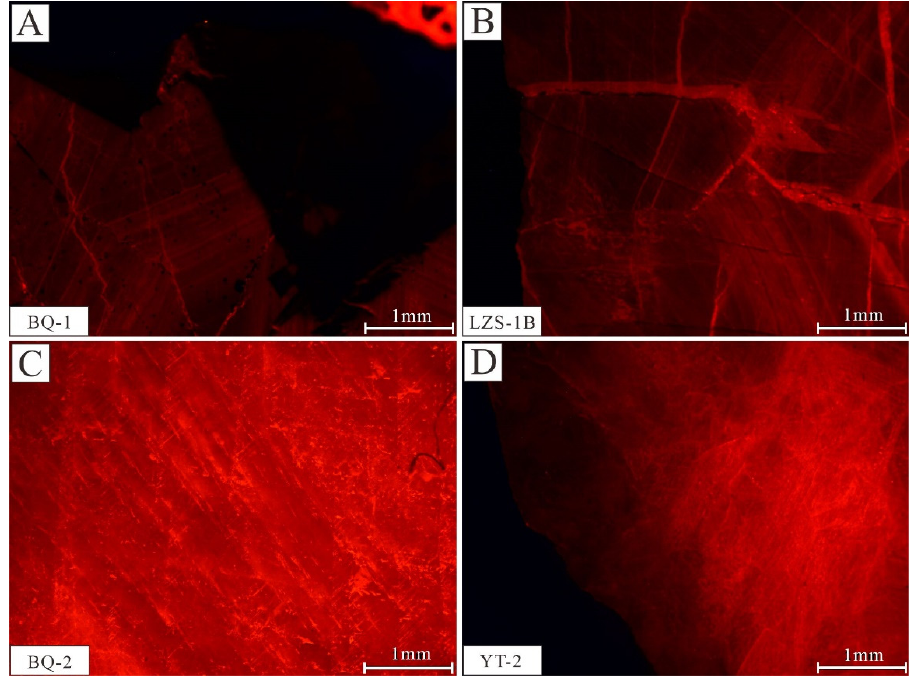
Figure 7. Cathode luminescence characteristics of calcite in the Laizishan-Banqi-Yata area, Nanpanjiang-Youjiang Basin. ( A ) Dark red cathodoluminescence of black calcite. ( B ) Dark red cathodoluminescence of gray calcite. ( C , D ) Bright red cathodoluminescence of white calcite. Table 3. Summary of fluid inclusion data of the various calcite types from the Nanpanjiang- Youjiang